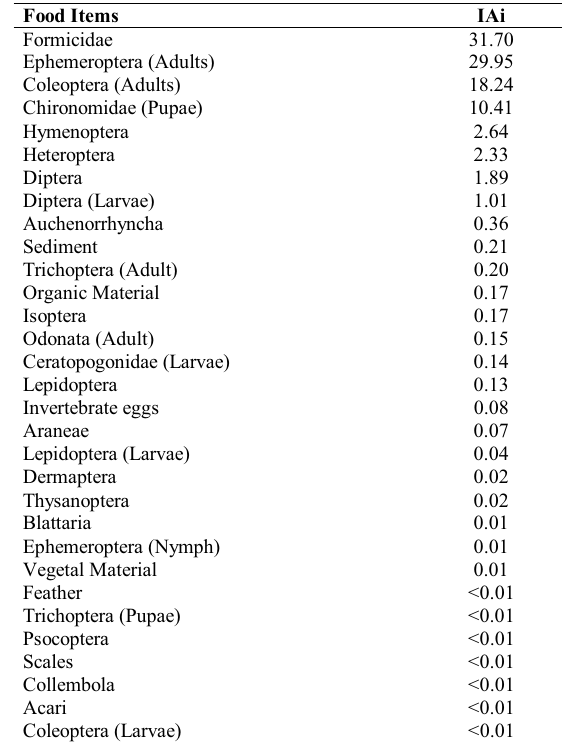
Table 1. Alimentary index (IAi) calculated for each food item in the diet of Thoracocharax stellatus in the upper rio Tocantins. Items with IAi > 1.00 were considered main items.